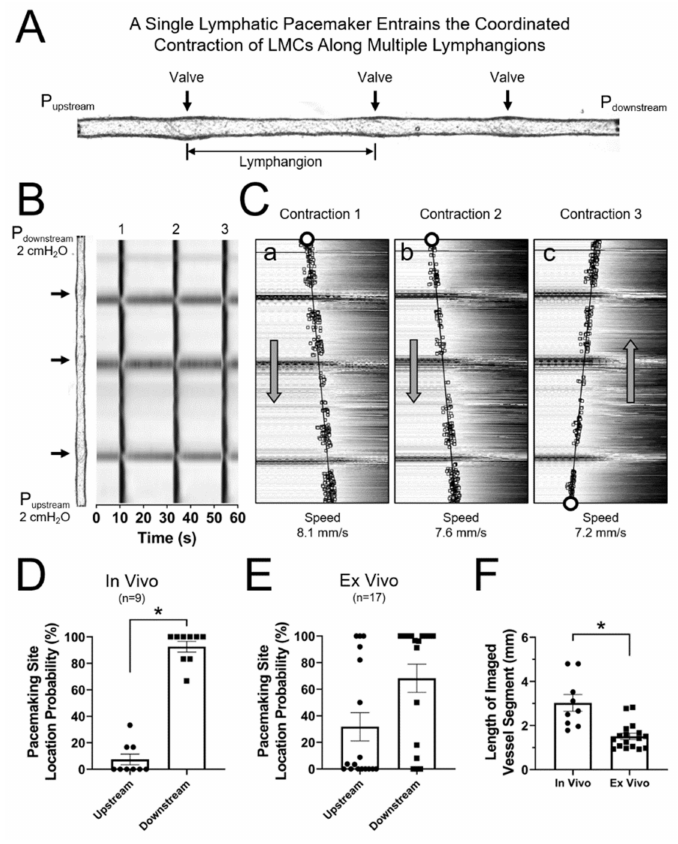
Figure 2. Assessment of the location of the initiation sites for contractions (i.e., pacemaking sites) in ex vivo preparations of popliteal lymphatic vessels: ( A ) A long isolated, cannulated, pressurized lymphatic segment containing 3 valves; ( B ) Three consecutive spontaneous contractions recorded from the lymphatic segment shown in panel A under equal upstream and downstream pressures (2 cmH 2 O); the image of the vessel is rotated 90 o and aligns with the STM. ( C ) Analysis of each individual contraction wave shows two contractions being initiated on the downstream (top) end of the lymphatic segment, while the last contraction originates from a pacemaking site located in the opposite (i.e., upstream) end. Pacemaking sites are represented by open markers (circles). Contraction waves associated with di ff erent pacemaking sites display comparable propagation speeds; ( D , E ) Pacemaking location probability in vivo and ex vivo respectively; ( F ) Length of lymphatic segments included in this analysis. * Indicates statistical significance ( p < 0.05) between